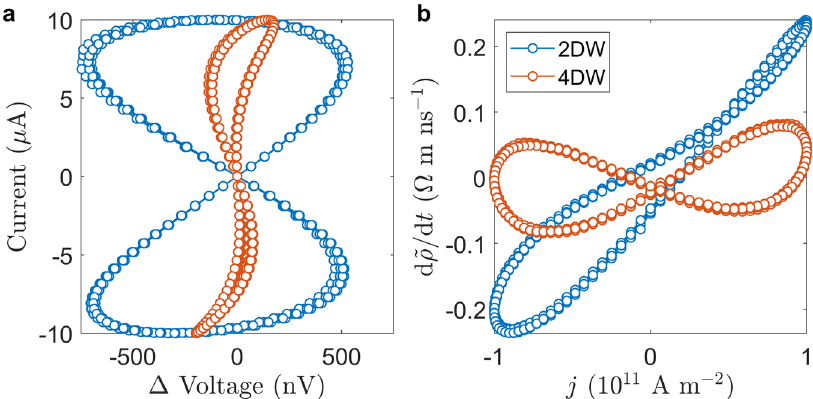
Fig. 5 Hysteresis curves for domain walls (DW). Resistivity of the 2DW and 4DW states. a Pinched hysteresis obtained from plotting the device current versus the change in voltage Δ V , in nanovolts. As we can see, the 2DW state has a larger change in voltage, which is of the order of 500 nV. b We plot the change in resistivity as a function of the current density, which is in units of 10 11 A m − 2 . As we can see, the domain-wall states have a larger memristive effect that the ground state and the in-plane states.